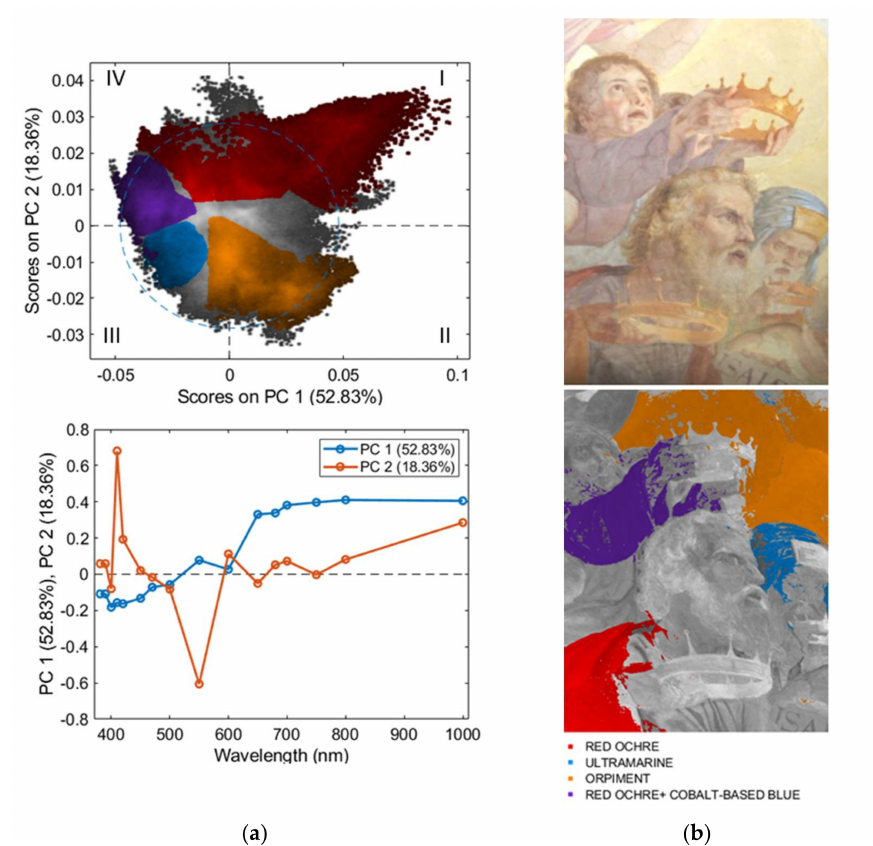
Figure 6. PCA score and loading plot of PC1 and PC2 ( a ) and relative false color image of AREA 1 ( b